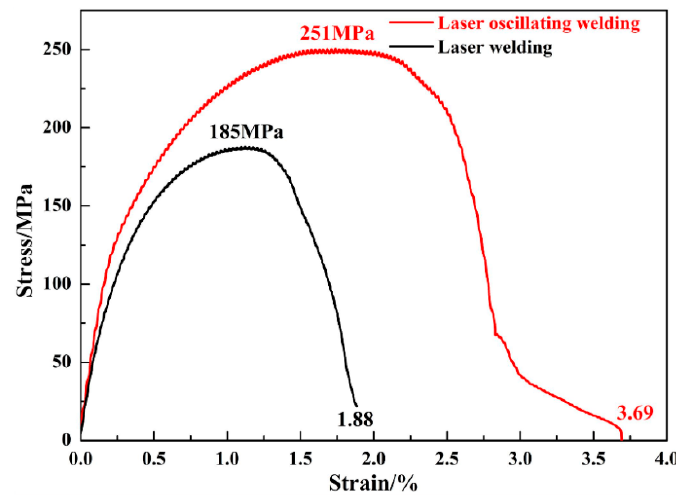
Figure 5. The stress-strain curves of the welded joints under different welding processes.